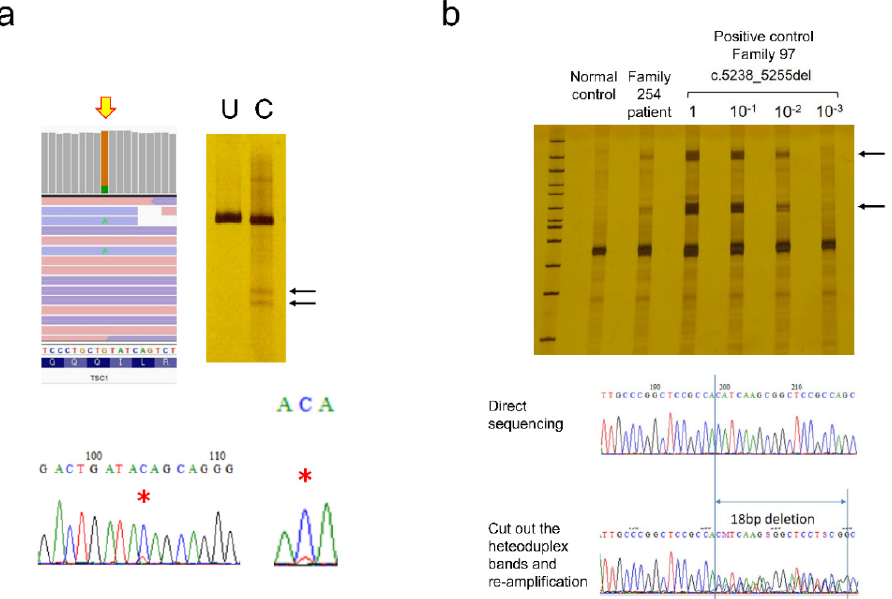
Figure 5. Examples of mosaic analysis. ( a ) TSC1 mosaic mutation, NM_000368.5:c.1960C>T p.(Gln654Ter), detected in family 267. CHIPS and Sanger sequencing detected this mosaic mutation (black arrows and red asterisks). ( b ) TSC2 very low-frequency mosaic mutation detected in family 254. NGS analysis (CoLAS) predicted TSC2 18bp deletion as a mosaic. Direct sequencing could not detect the mutation. As family 97 has the same mutation, a dilution series was made with control DNA, and CHIPS analysis was performed. When the heteroduplex bands (black arrows) were excised and sequenced, the 18 base pair deletion could be detected in the patient.